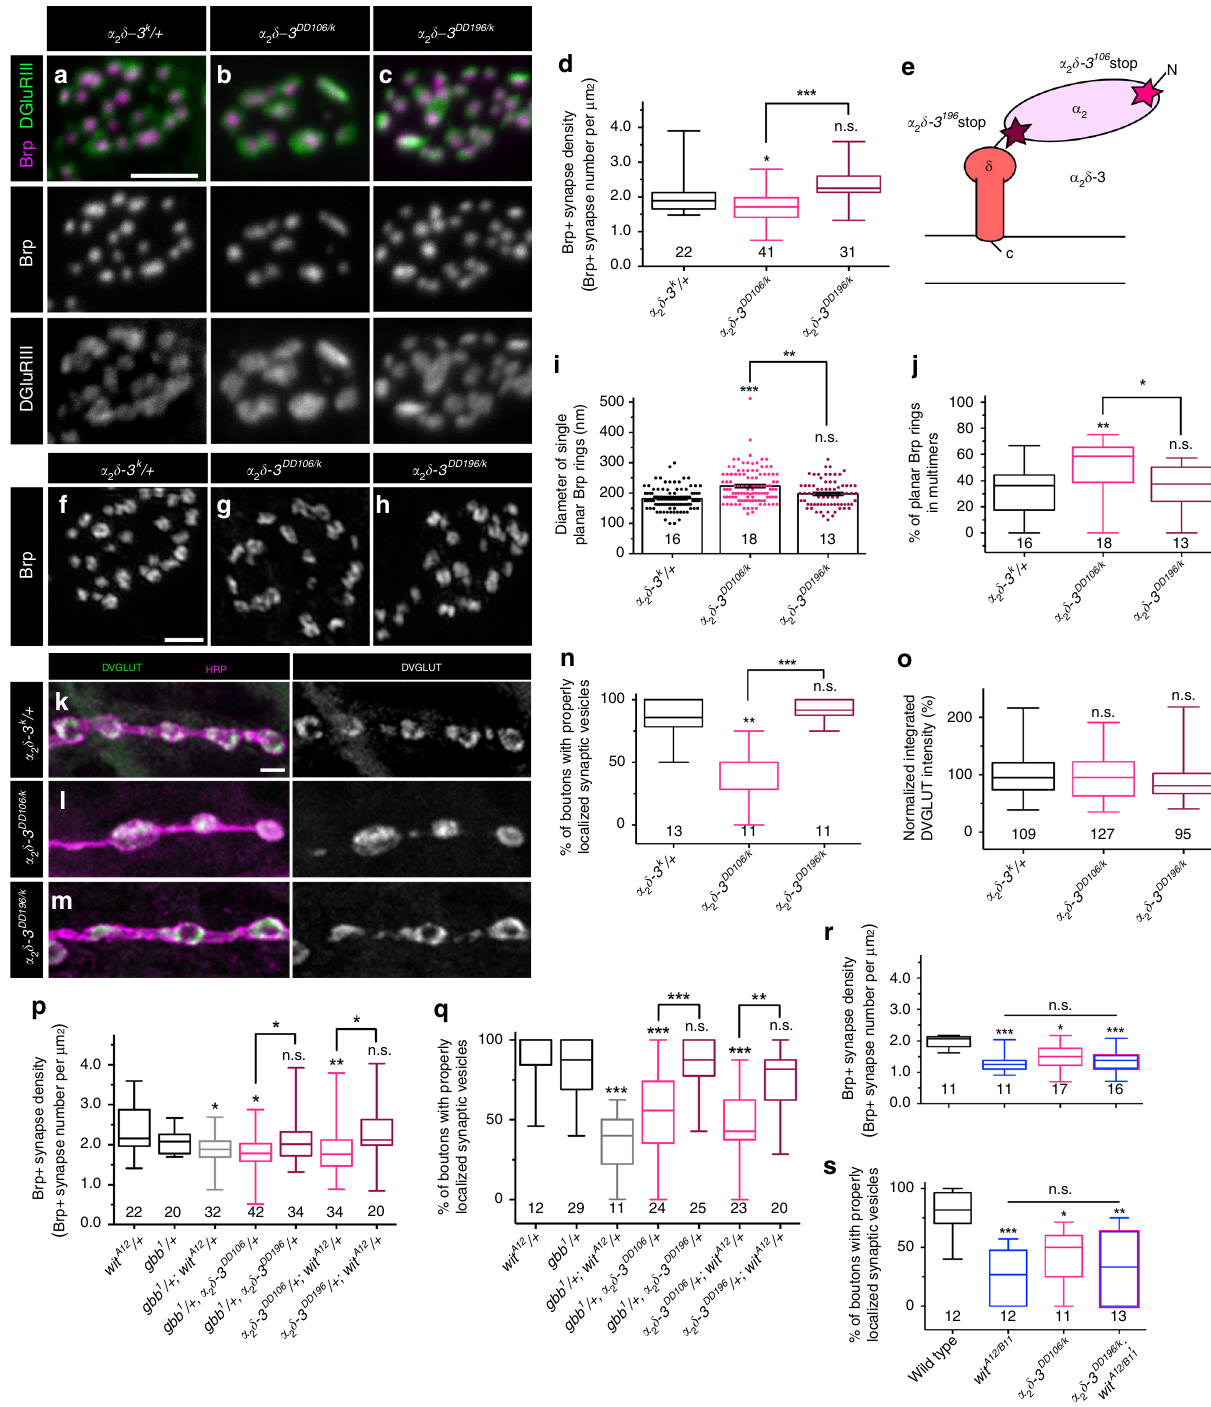
(Fig. 7p) and aberrant SSV distribution (Fig. 7q) similar to individual single mutants. Notably, the strength of the interac- tion between α 2 δ -3 DD106 and gbb or wit is as strong as the genetic interaction between gbb and wit (Fig. 7p, q). We next analyzed the phenotype of α 2 δ -3 DD106/k , wit A12/B11 double homozygotes. We fi nd that the phenotypes of α 2 δ -3 DD106/k , wit A12/B11 double mutants are no more severe than either individual single mutant (Fig. 7r, s). Together, these genetic interactions suggest that α 2 δ -3 functions in the autocrine BMP signaling